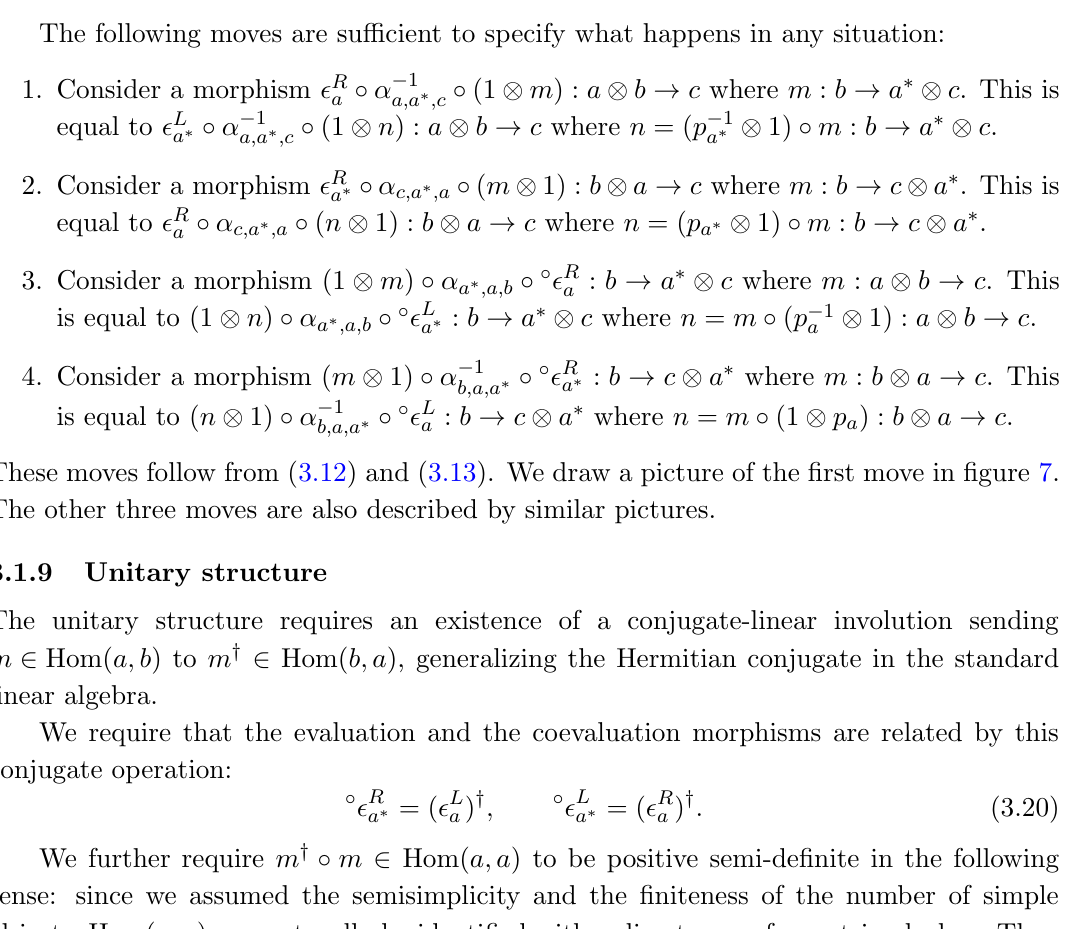
Figure 7 . The fold in the diagram on left hand side is speci(cid:12)ed as (cid:15) R speci(cid:12)ed as (cid:15) L . This changes the morphism from m on the left side to ( p (cid:0) 1 a (cid:3) side. These two diagrams provide two di(cid:11)erent categorical representations of the same physical